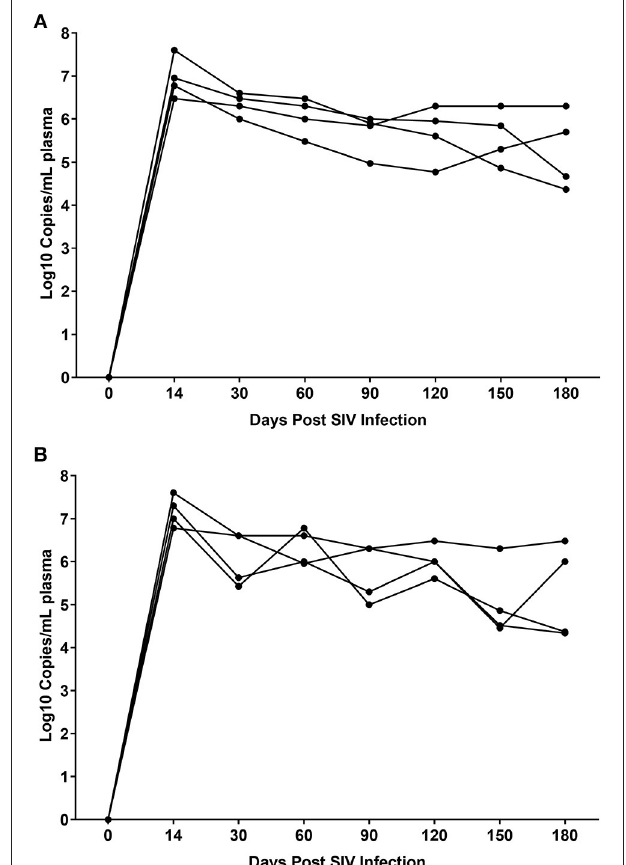
FIGURE 6 | Plasma viral loads in VEH/SIV (A) ( n = 4) and THC/SIV (B) ( n = 4) rhesus macaques through the course of SIV infection. Viral load measurements were performed once using 1-step RT-qPCR using four individual animals as biological replicates per group. Differences between groups at each post infection time point were analyzed using the Mann-Whitney U test employing the Prism v5 software (GraphPad software). Note the similarity in peak plasma viremia in both groups at 14 days post SIV infection. No statistical differences in plasma viral loads were detected between the two groups at all post infection time